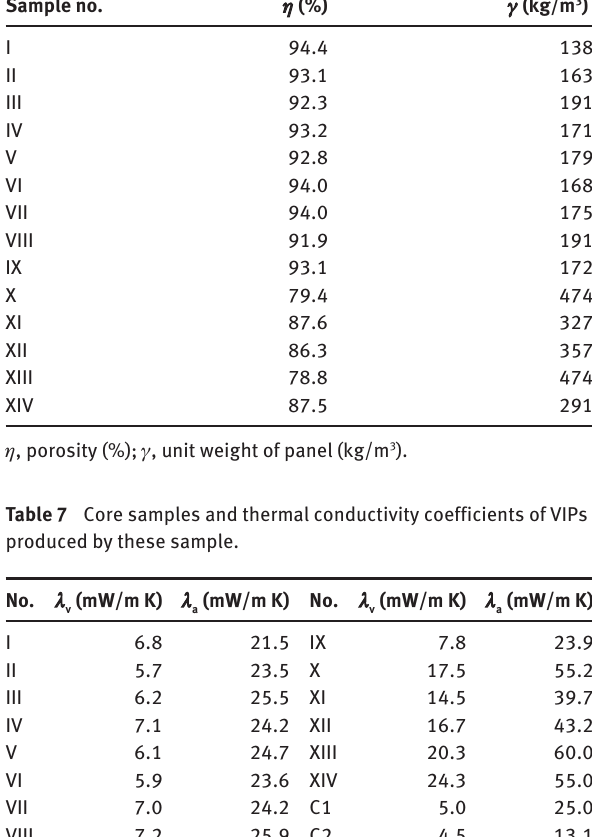
Table 6 Mass per volume and porosity values of VIP core samples. Sample no.